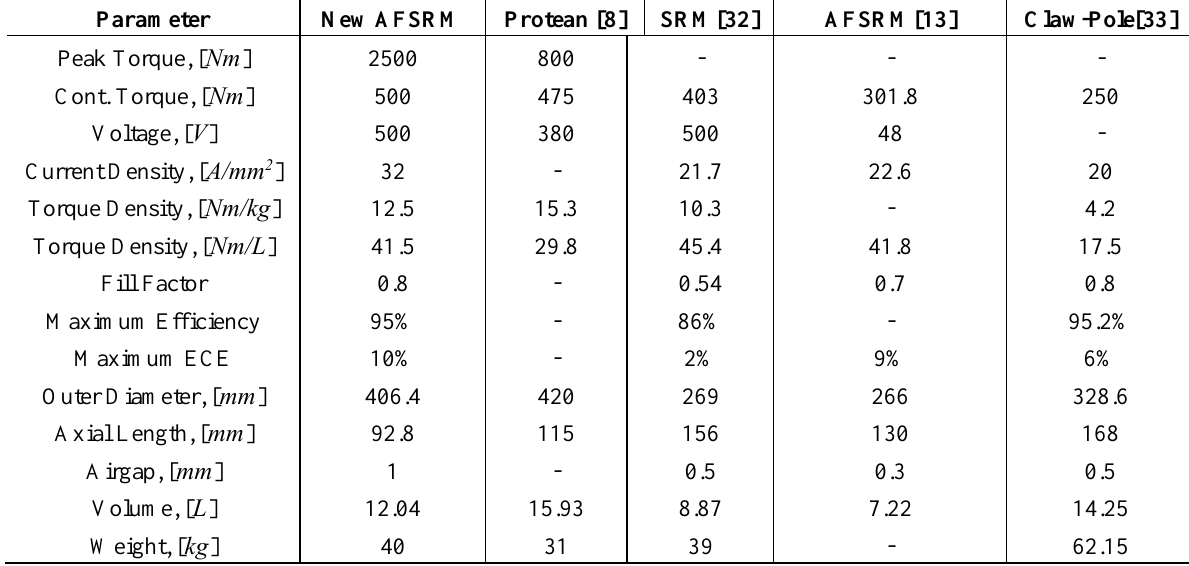
Table 4. Comparison of electric drive